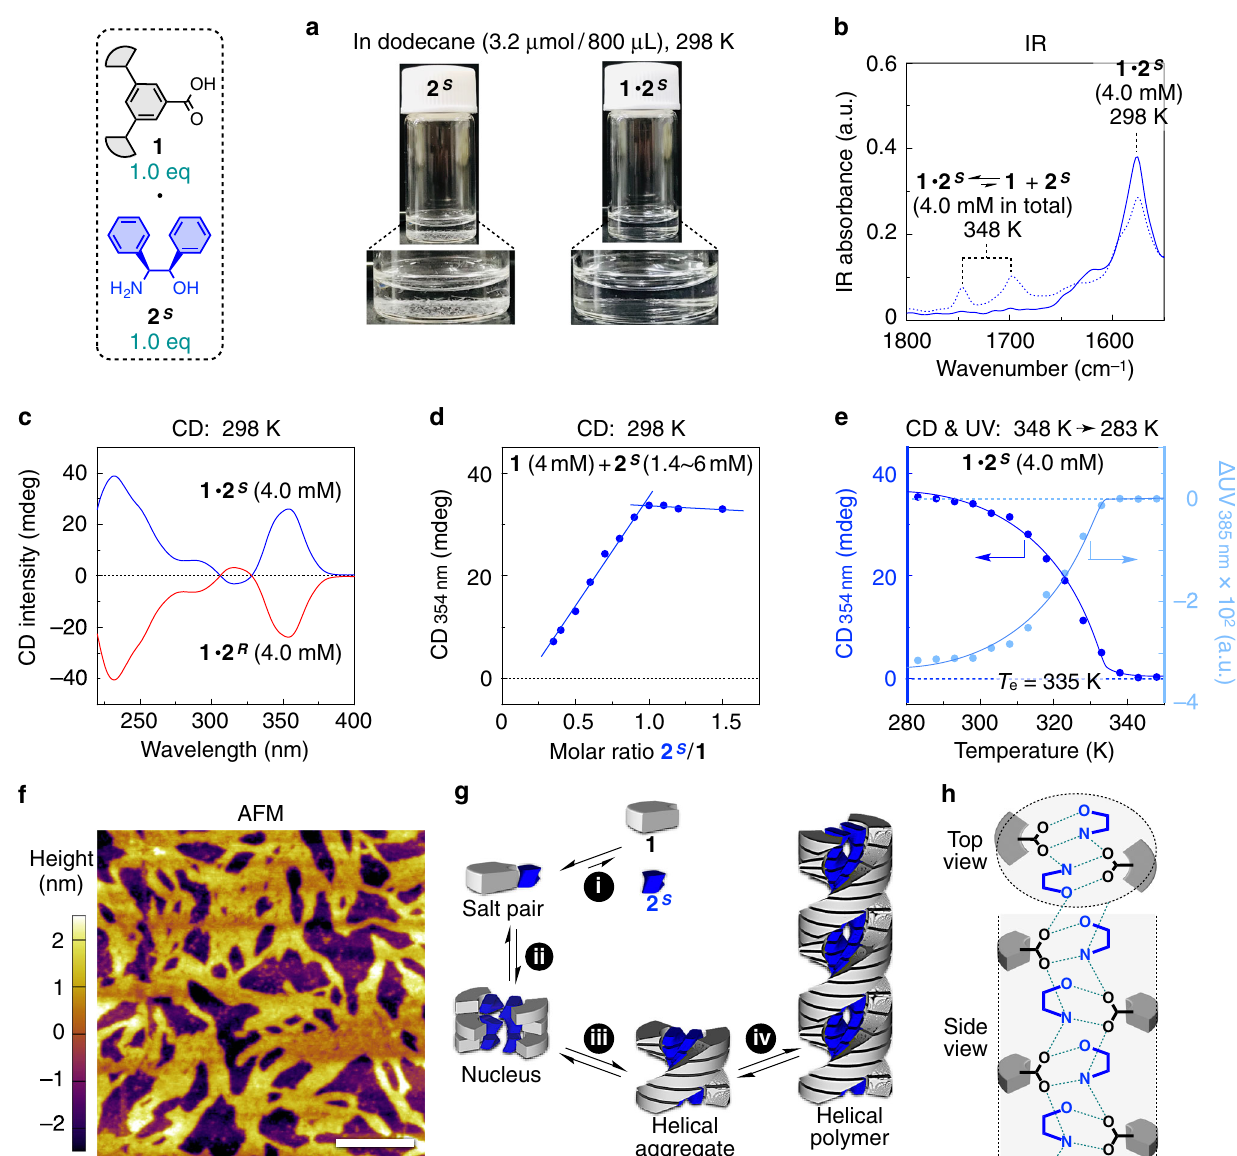
Fig. 2 Preparation and characterization the helical supramolecular polymer. a Solubility of 2 S (left) and their salt 1 ∙ 2 S (right) in dodecane (3.2 µ mol/800 µ L) at 298 K. b FT-IR spectra of 1 ∙ 2 S in dodecane (4.0 mM) at 298 (solid curve) and 348 K (dashed curve). c CD spectra of 1 ∙ 2 S and 1 ∙ 2 R in dodecane (4.0 mM) at 298 K. d CD (354 nm)-monitored titration of 1 (4.0 mM) with 2 S (1.4 – 6.0 mM) in dodecane at 298 K. e Cooling curves from 348 to 283 K at – 1.0 K/min of 1 ∙ 2 S in dodecane (4.0 mM) monitored with CD intensity at 354 nm and UV absorption at 385 nm. f AFM image of 1 ∙ 2 S spin-coated on a HOPG substrate from a dodecane solution (4.0 mM). Scale bar, 200 nm. For a magni fi ed image, see Supplementary Fig. 10a. g Schematic for the supramolecular polymerization of 1 and 2 S . h Helical hydrogen-bonded network generally formed in the crystal structures of carboxylate salts of 2 S ( 2 R ). See also Supplementary Fig.